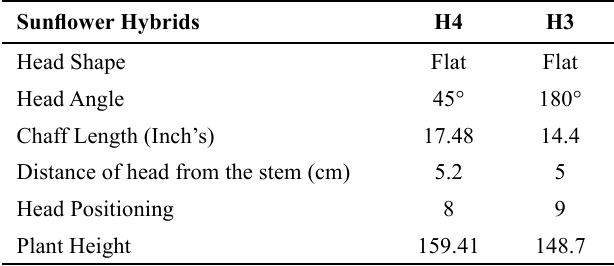
Table 1 . Plant Characteristics of bird resistant and susceptible in sunflower cultivars.